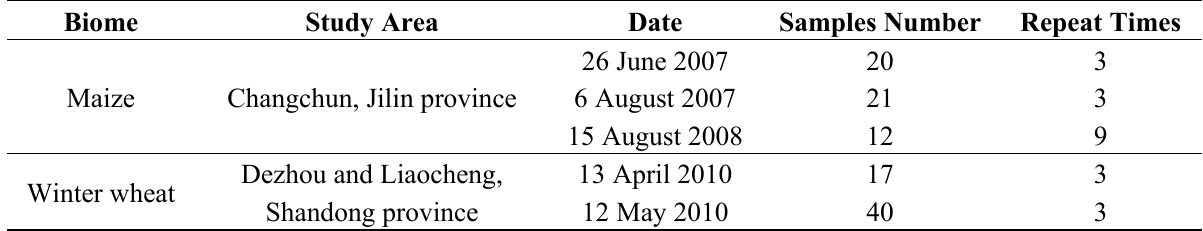
Table 2. Ground-measured FPAR data of maize and winter